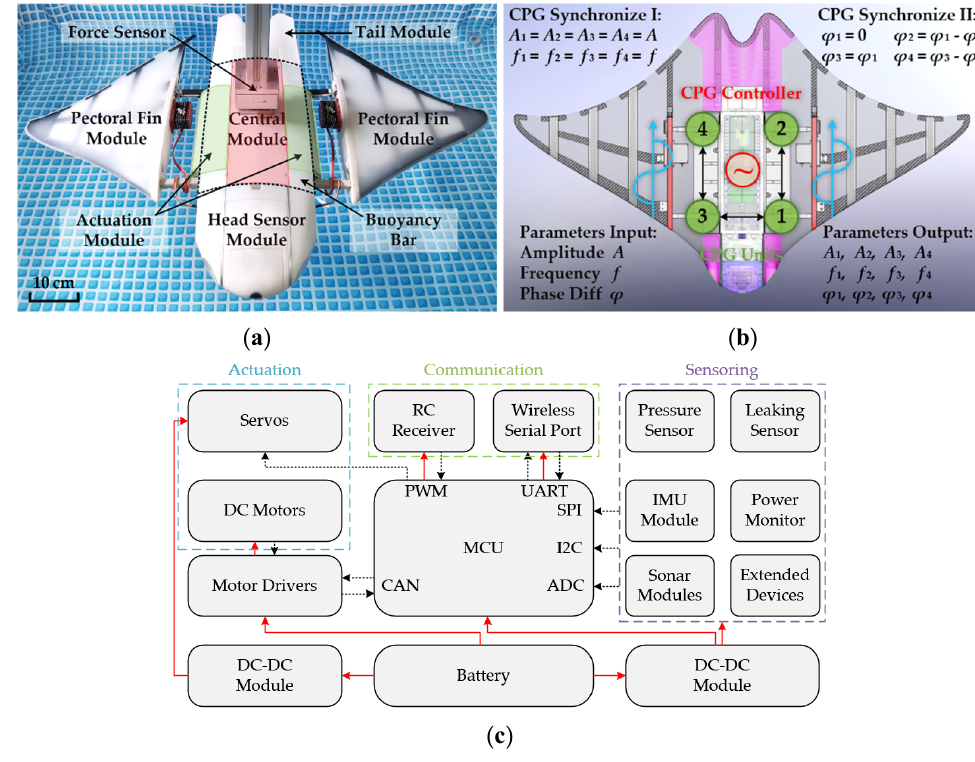
Figure 6. The ray-inspired robotic fish platform. ( a ) Photo of the modularized prototype; ( b ) The units and motion parameters of the CPG control method; ( c ) Schematic of the electronic hardware.